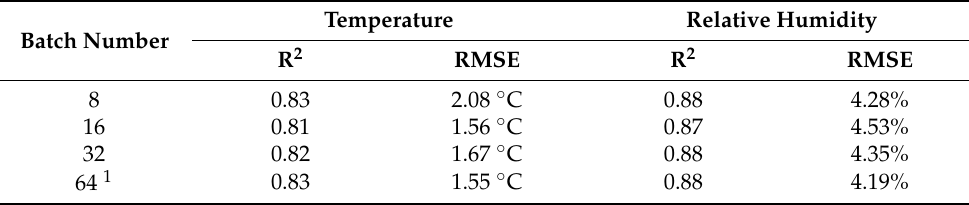
Table 4. Trial-and-error results of the batch number in the BPNN model. Batch